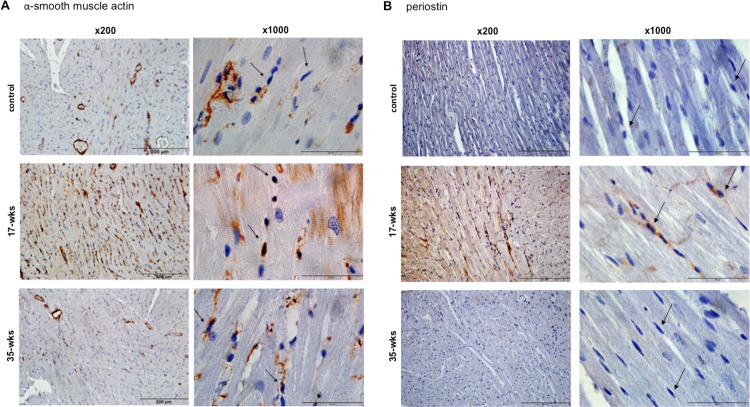
Myofibroblasts in the RV.SU5416-injected rats were subjected to 3 weeks in hypoxia and then maintained in normoxia for 14 or 32 weeks (17- and 35-wks time points, respectively). Hearts were fixed in formalin and embedded in paraffin. Longitudinal sections of the RV myocardium were subjected to immunohistochemistry using the antibody against (A) α-smooth muscle actin and (B) periostin. Results are presented at x200 and x1,000 magnifications. Scale bars indicate 200 μm for x200 and 50 μm for x1,000. The brown stains indicate the expression of α-smooth muscle actin or periostin. Arrows depict that neither α-smooth muscle actin nor periostin stains are present in fibroblasts of the normal RV; brown α-smooth muscle actin and periostin stains are present overlapping nuclear stains of fibroblasts at 17-wks; and α-smooth muscle actin and periostin stains in fibroblasts are absent at 35-wks.